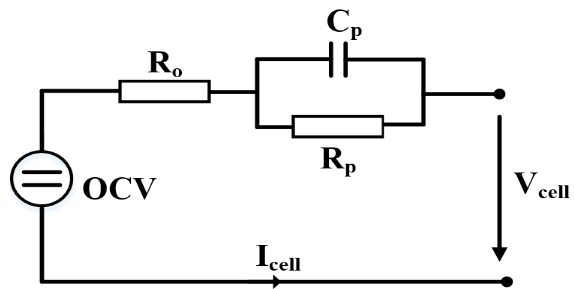
Figure 2. Thevenin equivalent circuit model for a Li-ion battery.